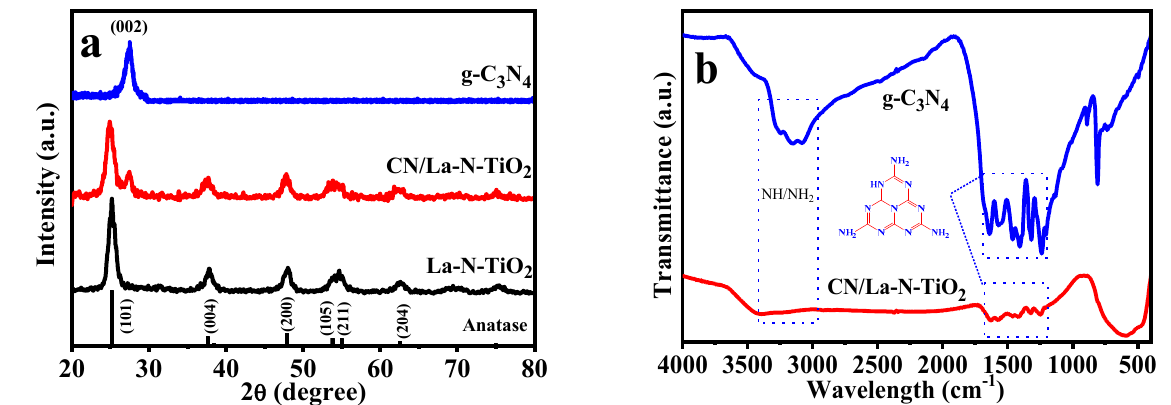
Figure 1. XRD patterns ( a ) of g-C 3 N 4 , La-N-TiO 2 , and CN/La-N-TiO 2 , and FTIR spectra ( b ) of La-N- TiO 2 and CN/La-N-TiO 2 .